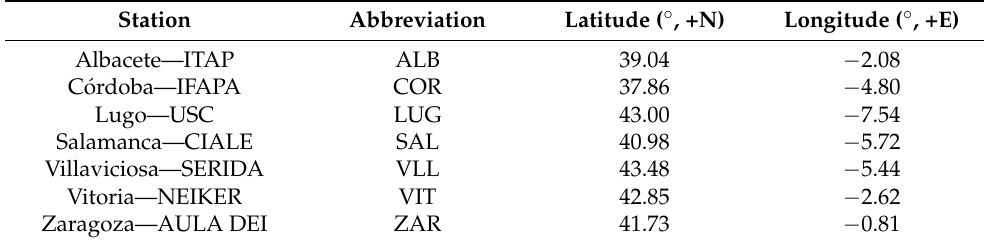
Table 1. Localization of PAR